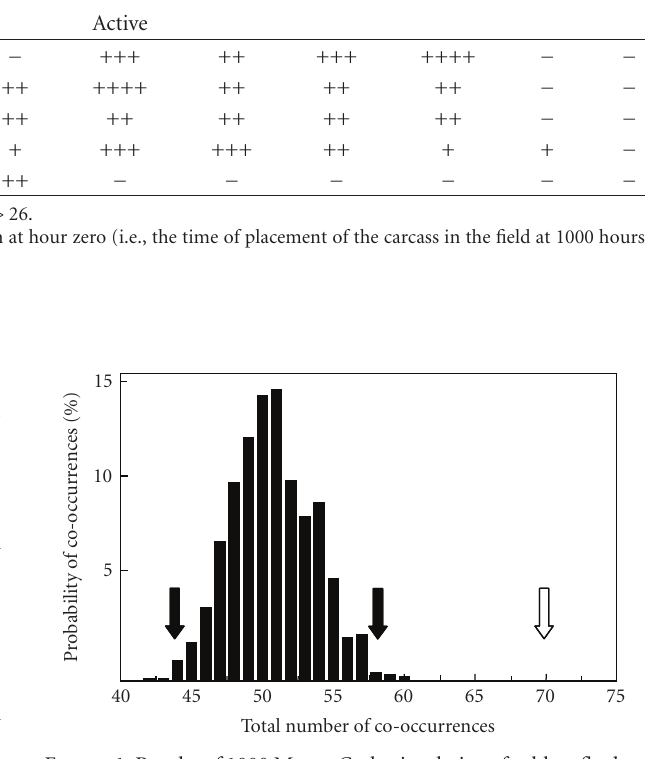
Table 3: Blow fly succession on site C’s decaying alligator, Mobile, Ala, USA (August 2002). Blow fly species